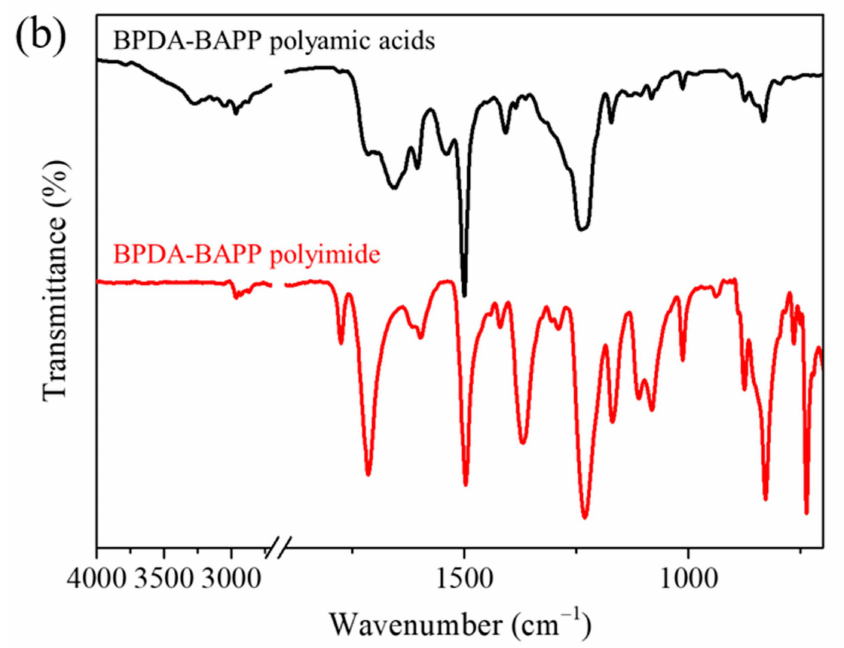
Figure 1. ( a ) 1 H-NMR spectra of the BPDA-BAPP and BPDA-HFBAPP. The a, b in this figure corresponds to the hydrogen proton of the carboxylic group and the hydrogen proton of amide, ( b ) FTIR spectra of fabricated BPDA-BAPP films before and after thermal